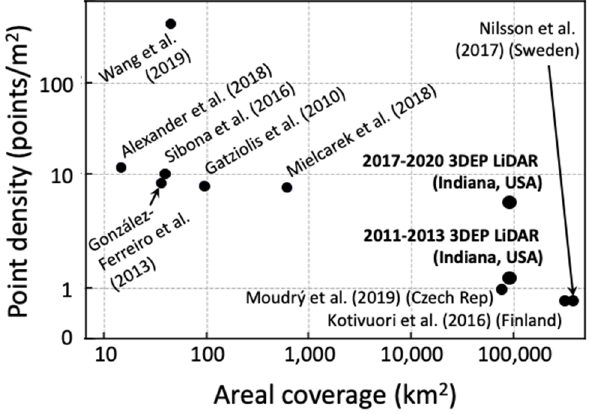
Figure 1. Areal coverage and point density of airborne LiDAR data.